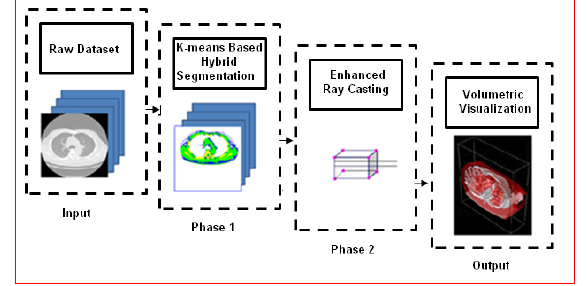
Figure 4. An overall view of the integrated visualization design.